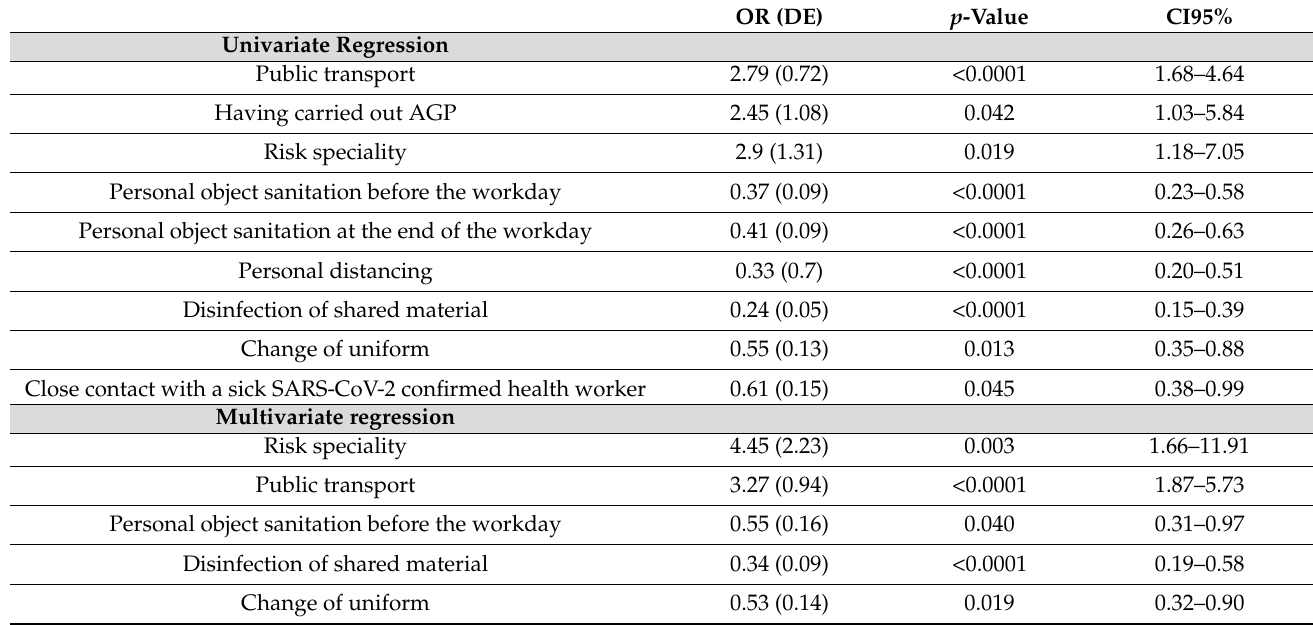
Table 7. Association of variables as risk/protective